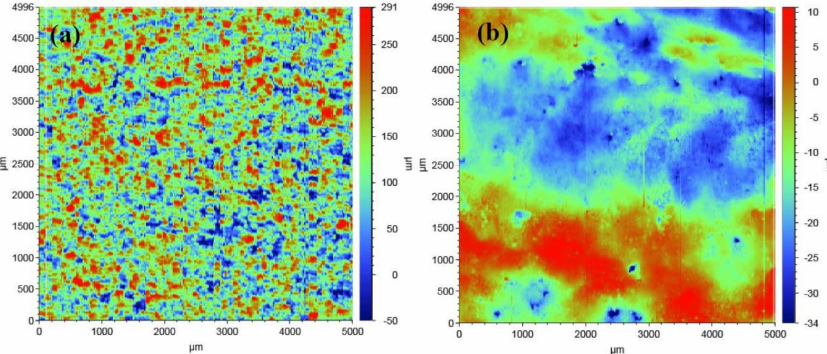
Figure 11. Roughness map scans between the ( a ) untreated and ( b ) treated